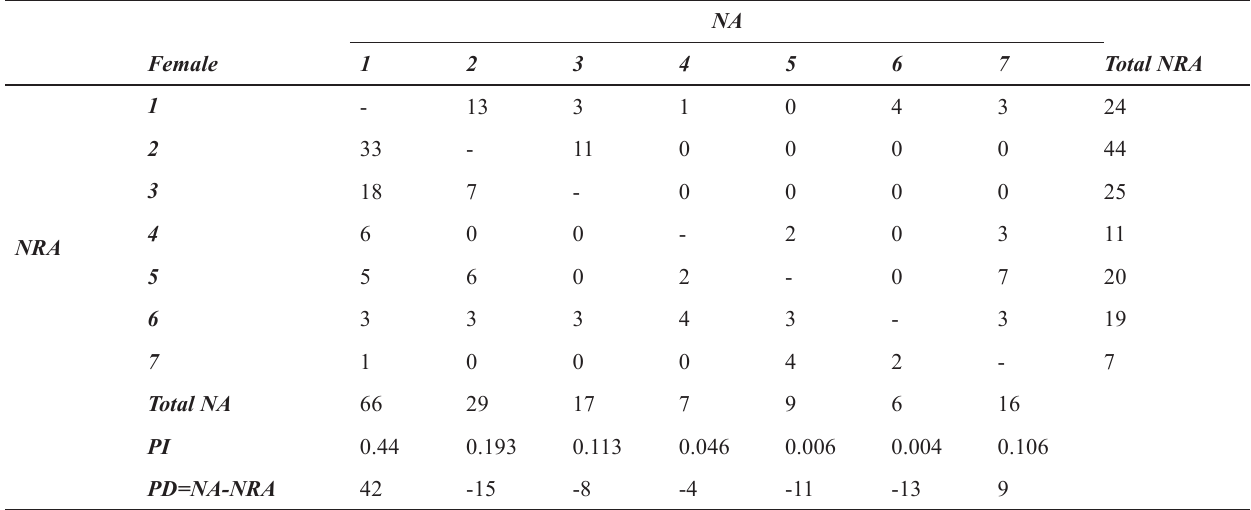
Table 2 . Agonistic interactions of seven nestmates in a sororal association of Euglossa annectans. NA = Number of attacks , NRA = Number of received a attacks, PI = Percentage of interaction, PD = Potential